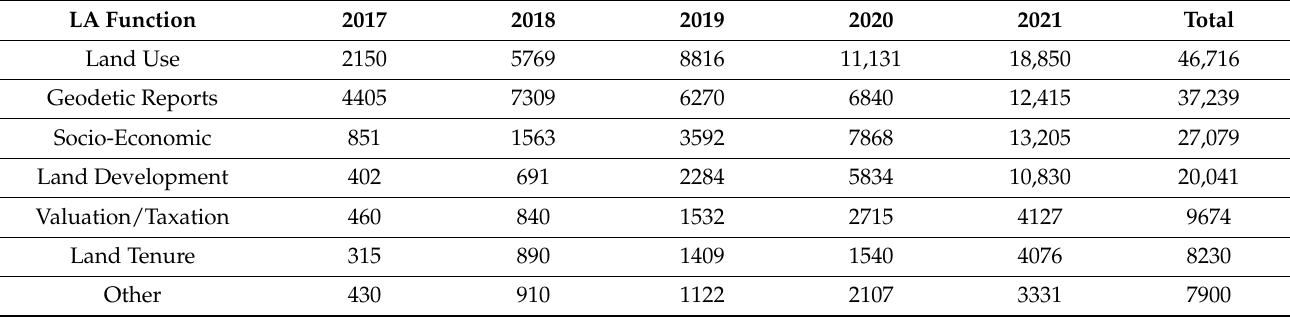
Table A1. Statistical data for dissemination of the Cadastral Map